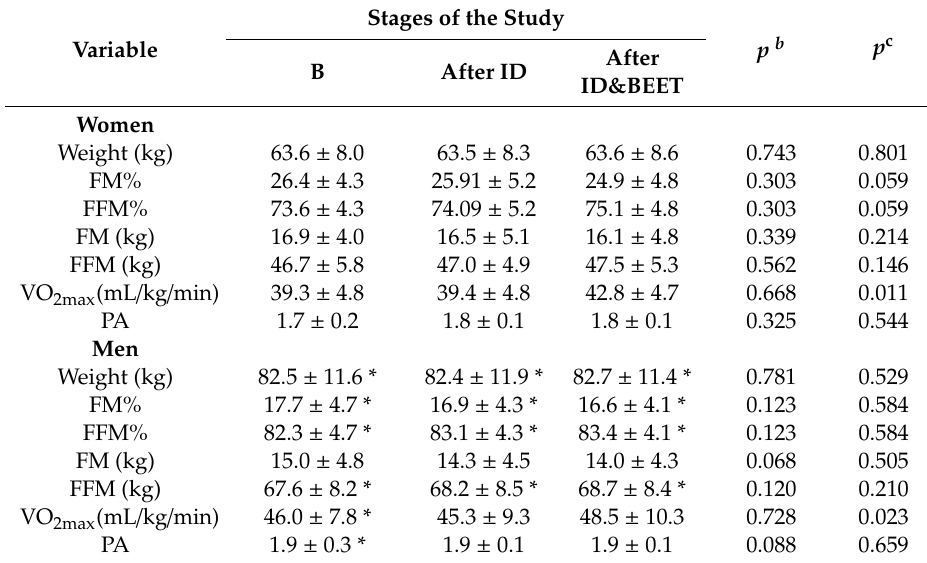
Table 1. Anthropometric parameters, mean physical activity level, and values of maximum rate of oxygen uptake at the studied groups of women and men in consecutive stages of the study (women, n = 10; men n = 10) a